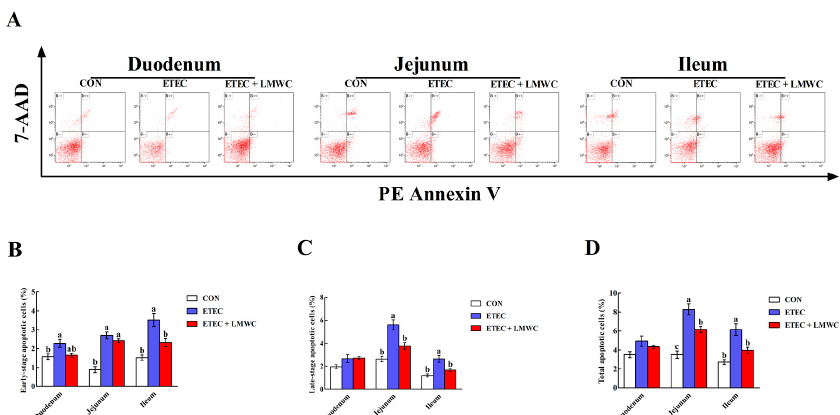
Figure 8. E ff ects of low-molecular-weight chitosan on the epithelial cell apoptosis in the small intestine of weaned pigs challenged with enterotoxigenic Escherichia coli . ( A ) Representative scattergram of apoptotic epithelial cells in the small intestine of weaned pigs among the three groups. ( B ) Early-stage apoptotic cells. ( C ) Late-stage apoptotic cells. ( D ) Total apoptotic cells. a–c Means with di ff erent letters on vertical bars indicate significant di ff erences ( P < 0.05). Values are means ( n = 8 pigs / treatment), with standard errors represented by vertical bars. CON: non-infected control (pigs received the basal diet and infused with sterilised Luria–Bertani culture); ETEC: ETEC-infected control (pigs received the basal diet and infused with enterotoxigenic Escherichia coli ); ETEC + LMWC: pigs received the basal diet supplemented with 100 mg / kg low-molecular-weight chitosan and infused with enterotoxigenic Escherichia coli . Cells that stain negative for PE Annexin V and positive for 7-AAD are necrotic cells (B − + ); cells that stain positive for both PE Annexin V and 7-AAD are in the late-stage of apoptosis (B ++ ); cells that stain negative for both PE Annexin V and 7-AAD are normal cells (B −− ); cells that stain positive for PE Annexin V and negative for 7-AAD are undergoing the early-stage of apoptosis (B + − ). 7-AAD, 7-aminoactinomycin D.